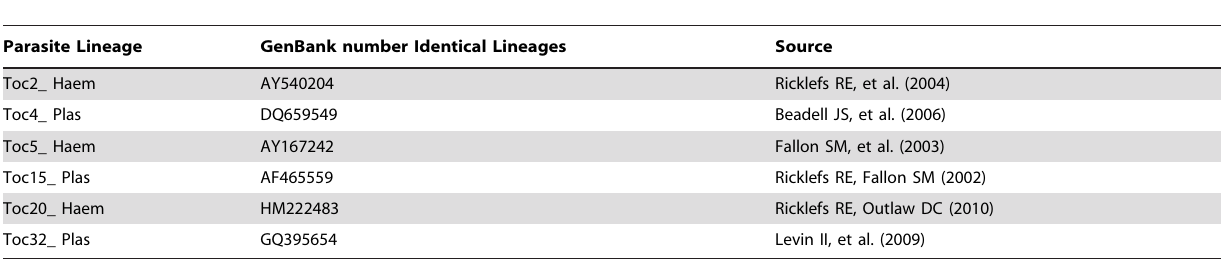
Table 2. Relation of parasites lineages already related in others